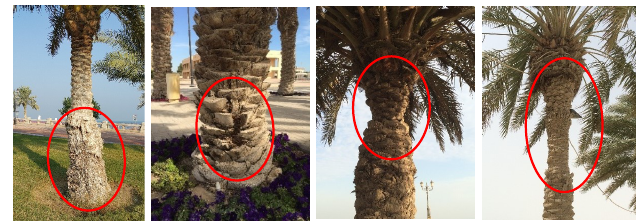
Figure 4: Some forms of deformation along the bottom, middle and upper thirds of the palm trees